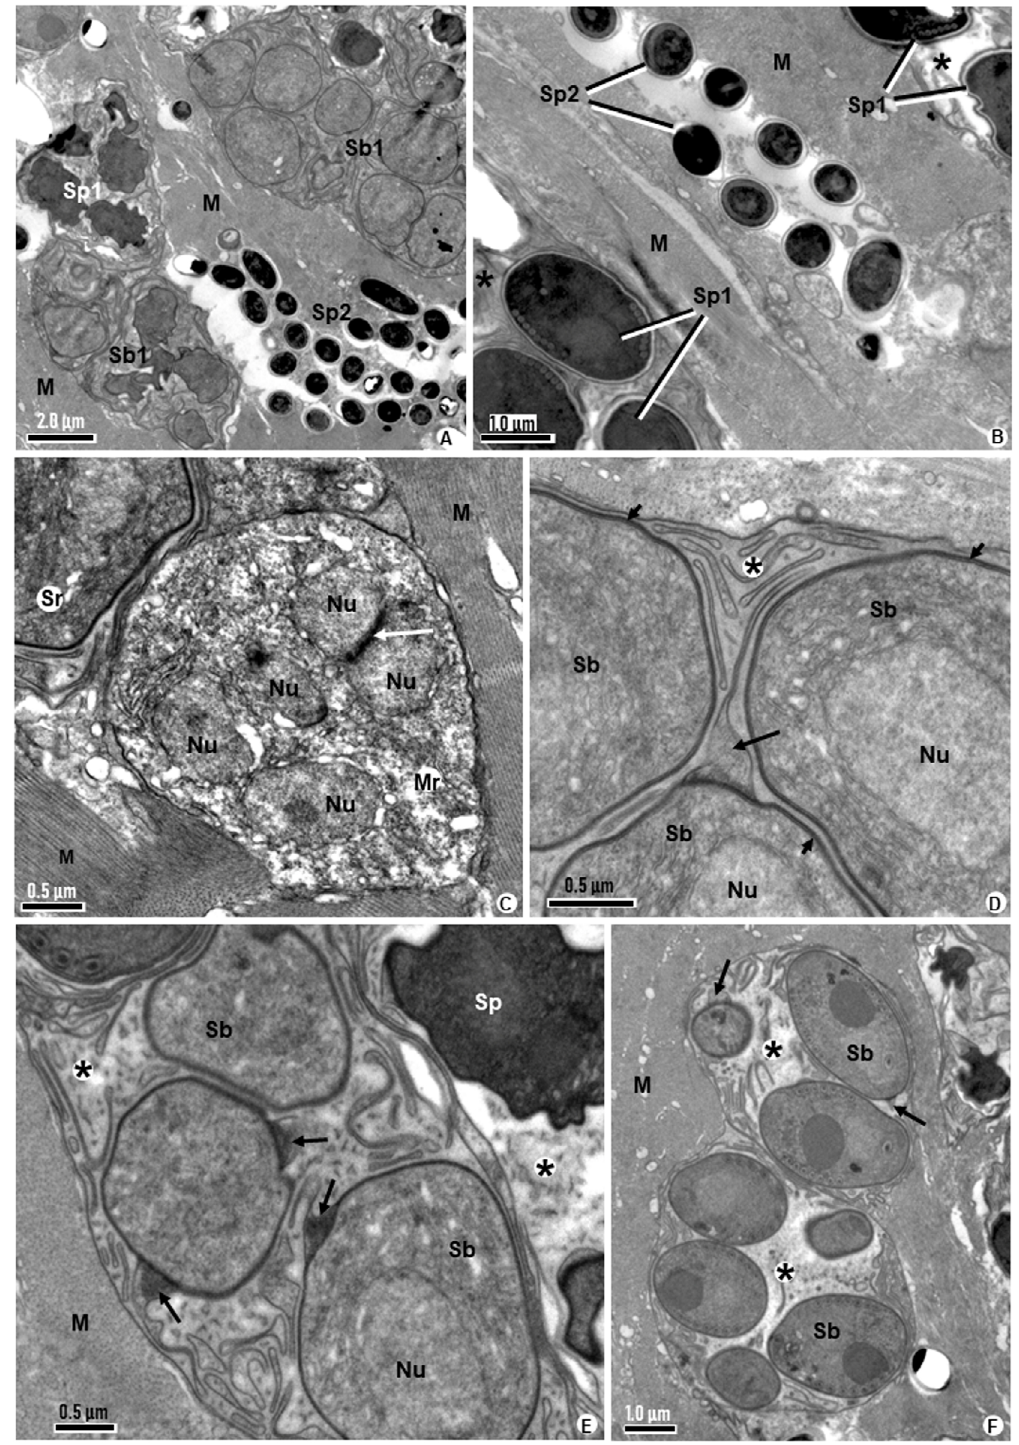
Figure 2. Inodosporus sp. (Sp. 1) and Myospora sp. (Sp. 2) observed in TEM. ( A ) Two morphologically different spores (Sp1 and Sp2) and intracellular stages (Sb1 - sporoblasts). ( B ) Two sporophorous vacuoles (*) containing Sp. 1 spores, and several Sp. 2 free spores located in the central position among muscle fibers. ( C ) Plasmodium with several nuclei and a meront (Mr) in the view. White arrow indicates the diplokaryon phase. Sr, sporont of the Sp. 1. ( D ) Sporophorous vacuole (*) showing early sporoblasts (Sb) of the Sp. 1 and their nuclei (Nu). A precursor of the tail-like appendage (long arrow) attached to the sporoblast wall (small arrows). ( E ) Two adjacent sporophorous vacuoles (*) in muscle (M): left vacuole contains early sporoblasts with the precursors of the tail-like appendages (arrows), right vacuole is filled with spores (Sp). ( F ) Two sporophorous vacuoles (*) containing late sporoblasts (Sb) some of which demonstrate precursors of the tail-like appendages on the sporoblast walls